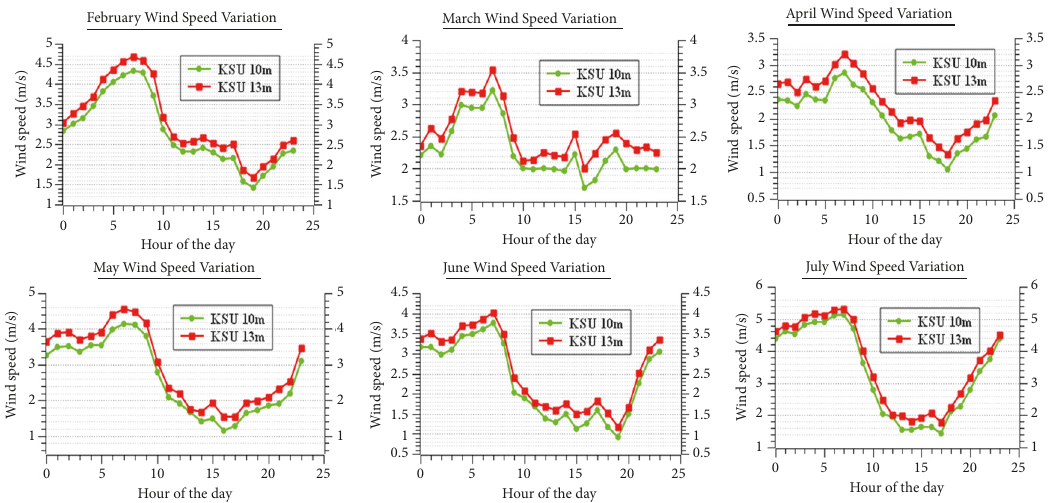
Figure 8: Kisii University (KSU) site diurnal variation of wind speeds for months of February to